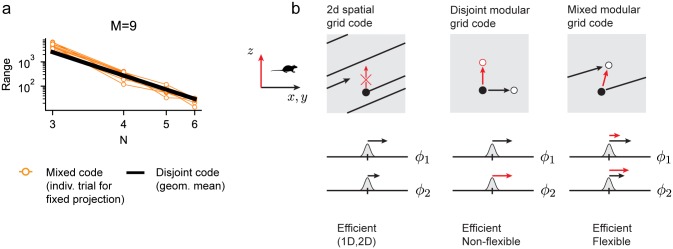
Flexibility of the mixed modular grid code: Conceptual explanation.(a) Change of coding range while increasing the dimensionality of the input (N) and keeping the projection fixed (per trial), illustrating the flexibility of the scheme (10 trials are shown). (b)
Left: The conventional grid code encodes only 2D variables (x, y, black arrows; and not z, red); movements in x, y result in phase changes across modules, but changes in z do not. These phase changes evolve along only one direction in the coding space (here, showing 2 modular phases), governed by the ratios of the grid periods. Middle: The disjoint grid module code: Modules are partitioned into disjoint groups, one set coding x, y, the other coding z. Changes in x, y update one set of phases, changes in z another; the red circle cannot be reached from the black by only changing x, y, without changing z. Right: Updates in module activity are decoupled as for the disjoint code but each module participates in the representation of all input dimensions. The periodicity of the code makes it possible to reach (and thus use) the white coding state from the black in two ways: by moving along x, y, or along z (red and black arrows).